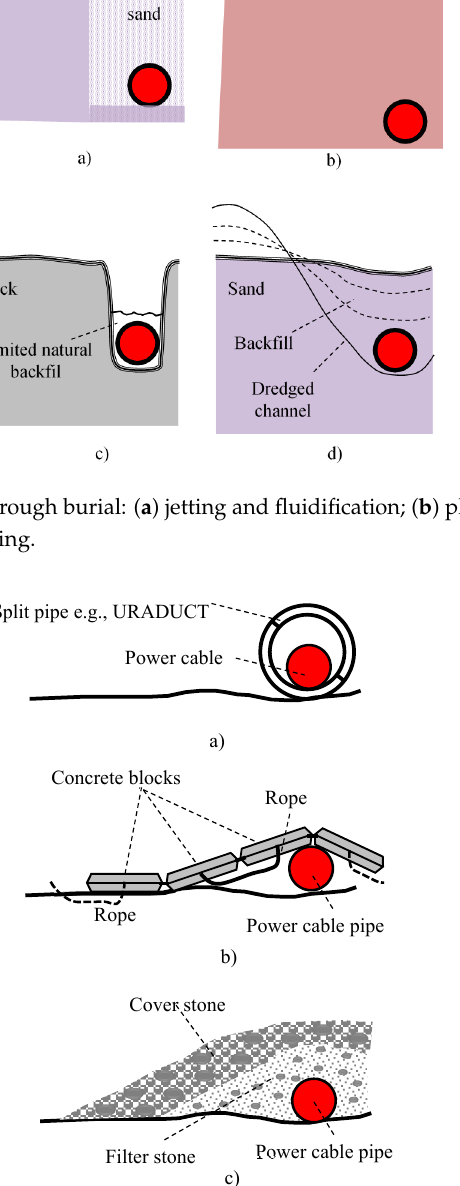
Figure 5. Special cable protections: ( a ) tubular product; ( b ) mattress covering; ( c ) rock dumping.